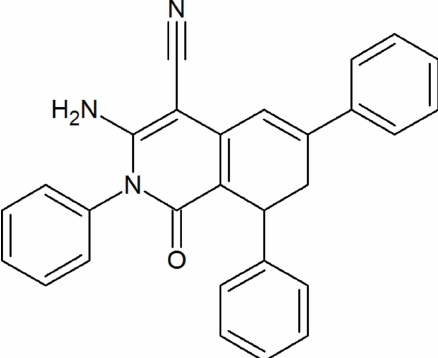
Table 1 Hydrogen-bond geometry (A˚ , (cid:2) ).